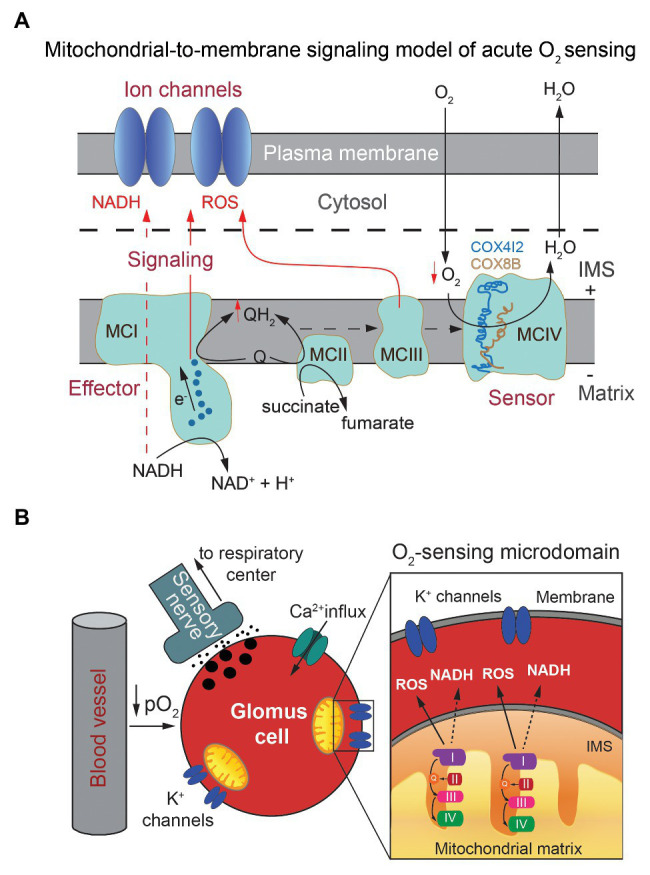
Mitochondria-to-membrane signaling model of acute oxygen sensing by glomus cells. (A) Scheme illustrating the mitochondrial signals (NADH and ROS) generated upon exposure to hypoxia and their interaction with membrane ion channels. Modified from Moreno-Dominguez et al. (2020). (B) Model of chemosensory transduction by O2-sensing glomus cells in the carotid body. Modified from Fernandez-Aguera et al. (2015).